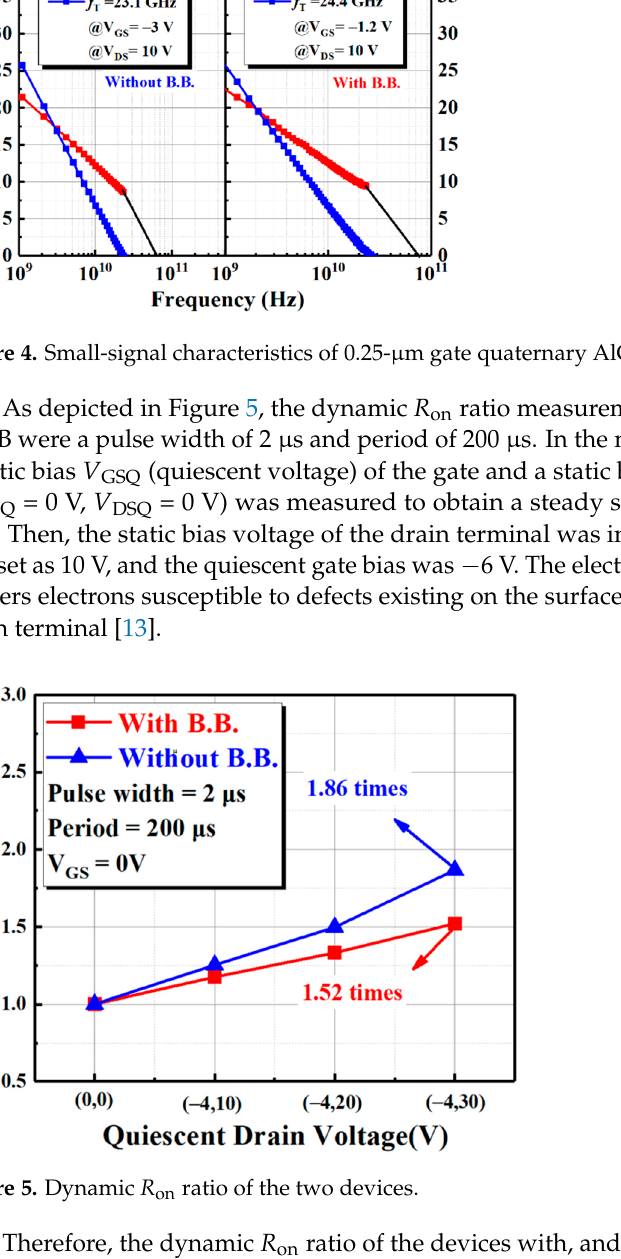
Figure 5. Dynamic R on ratio of the two devices.